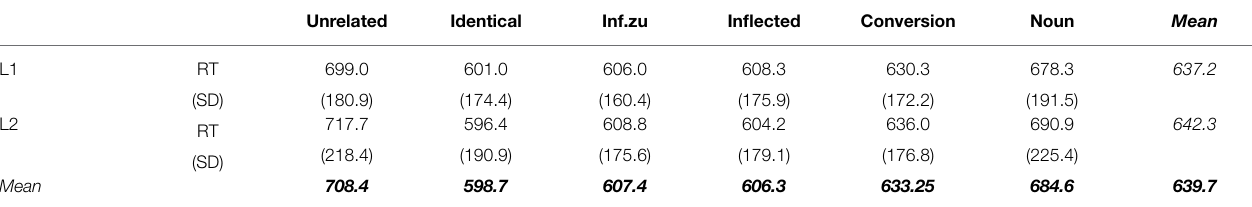
TABLE 2 | Experiment 1: mean reaction times for target phrases in ms, standard deviations (in